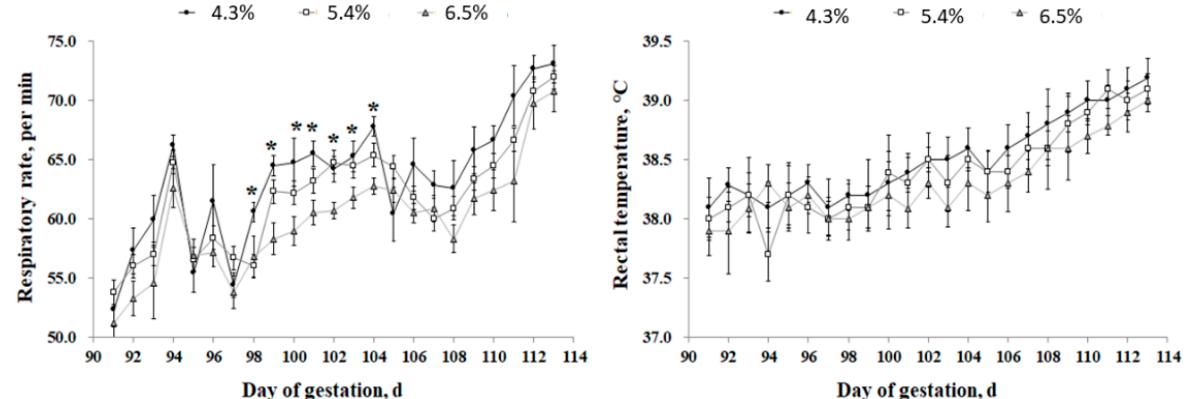
Figure 1. Effect of dietary acid detergent fiber levels in gestation diets on respiratory rate and rectal temperature of sows from day 90 to 114 under high ambient temperatures. Values represent means ± standard error. Asterisks (*) indicate statistical significance ( p < 0.05).